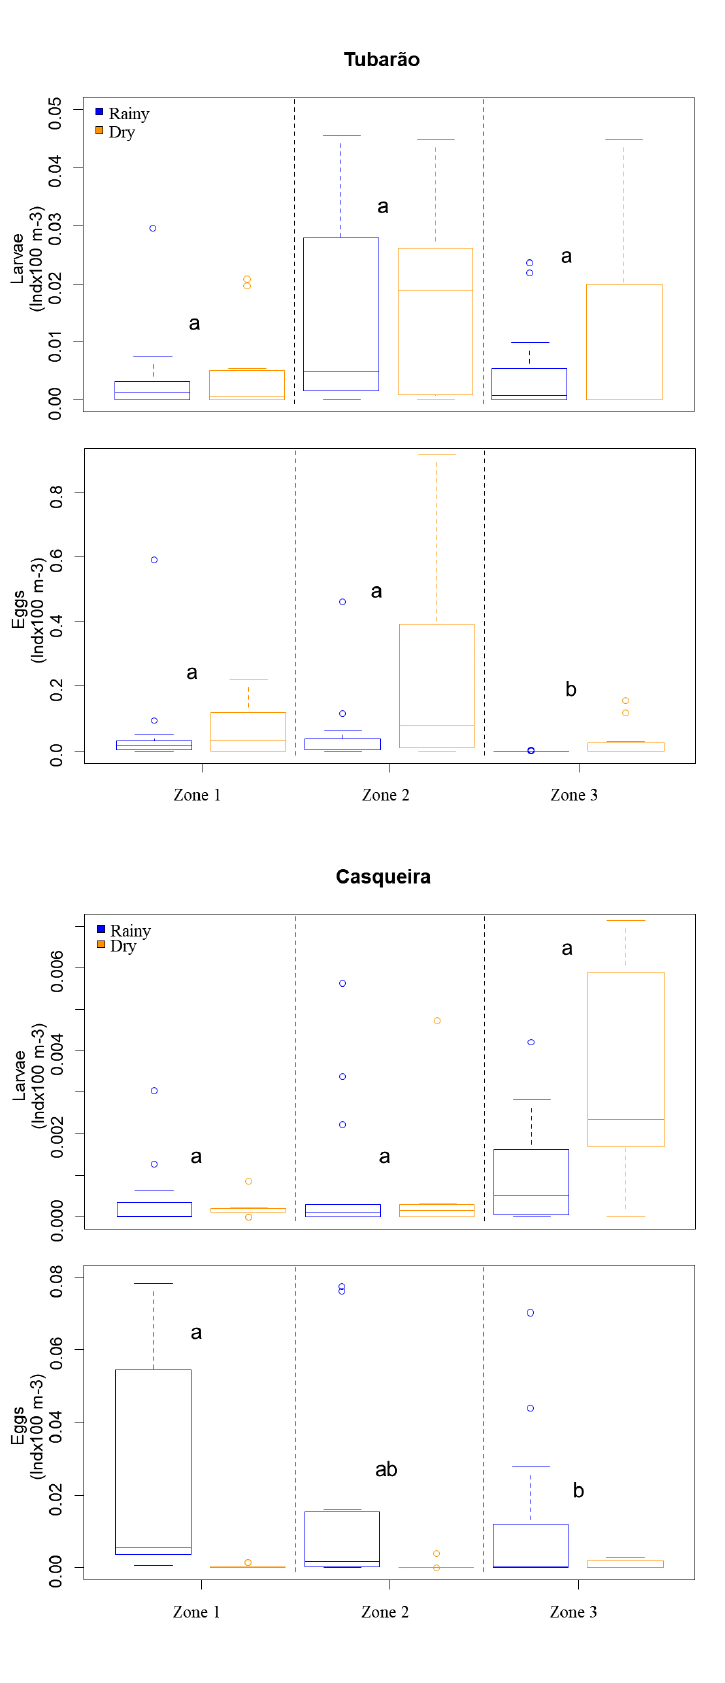
FIGURE 2 | Box Plots of larvae (Ind * 100 -3 ) and egg (Ind * 100 - 3 ) densities in three zones of each of estuaries (Tubarão and Casqueira rivers) during their dry and rainy periods. Different letters indicate significant differences (P <